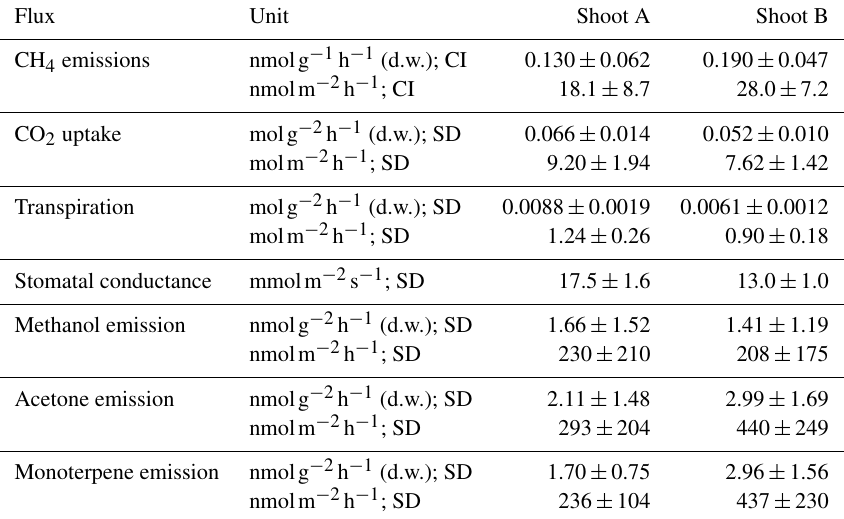
Table 3. Shoot fluxes and stomatal conductance measured in this study scaled to foliar dry weight and leaf area after subtracting empty- chamber fluxes. All uncertainties include the uncertainties in shoot and blank (empty-chamber) measurements and are stated as standard deviations (SDs) or 95% confidence intervals